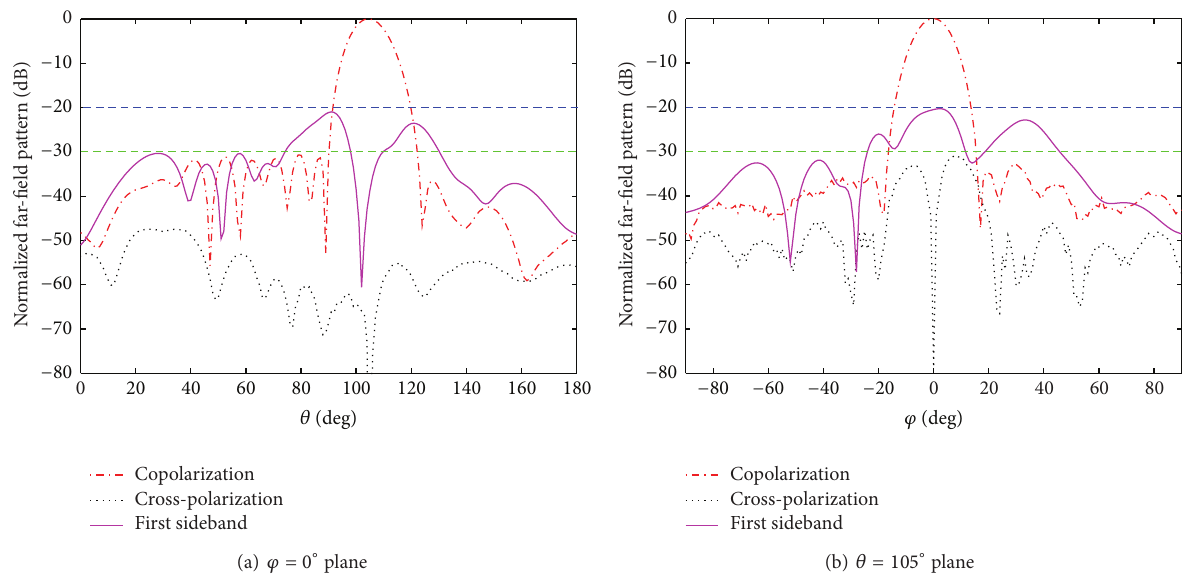
Figure 16: Sectional views in the elevation and azimuth planes for scan direction of (105 ∘ ,0 ∘ ) for solution A in Figure 7.